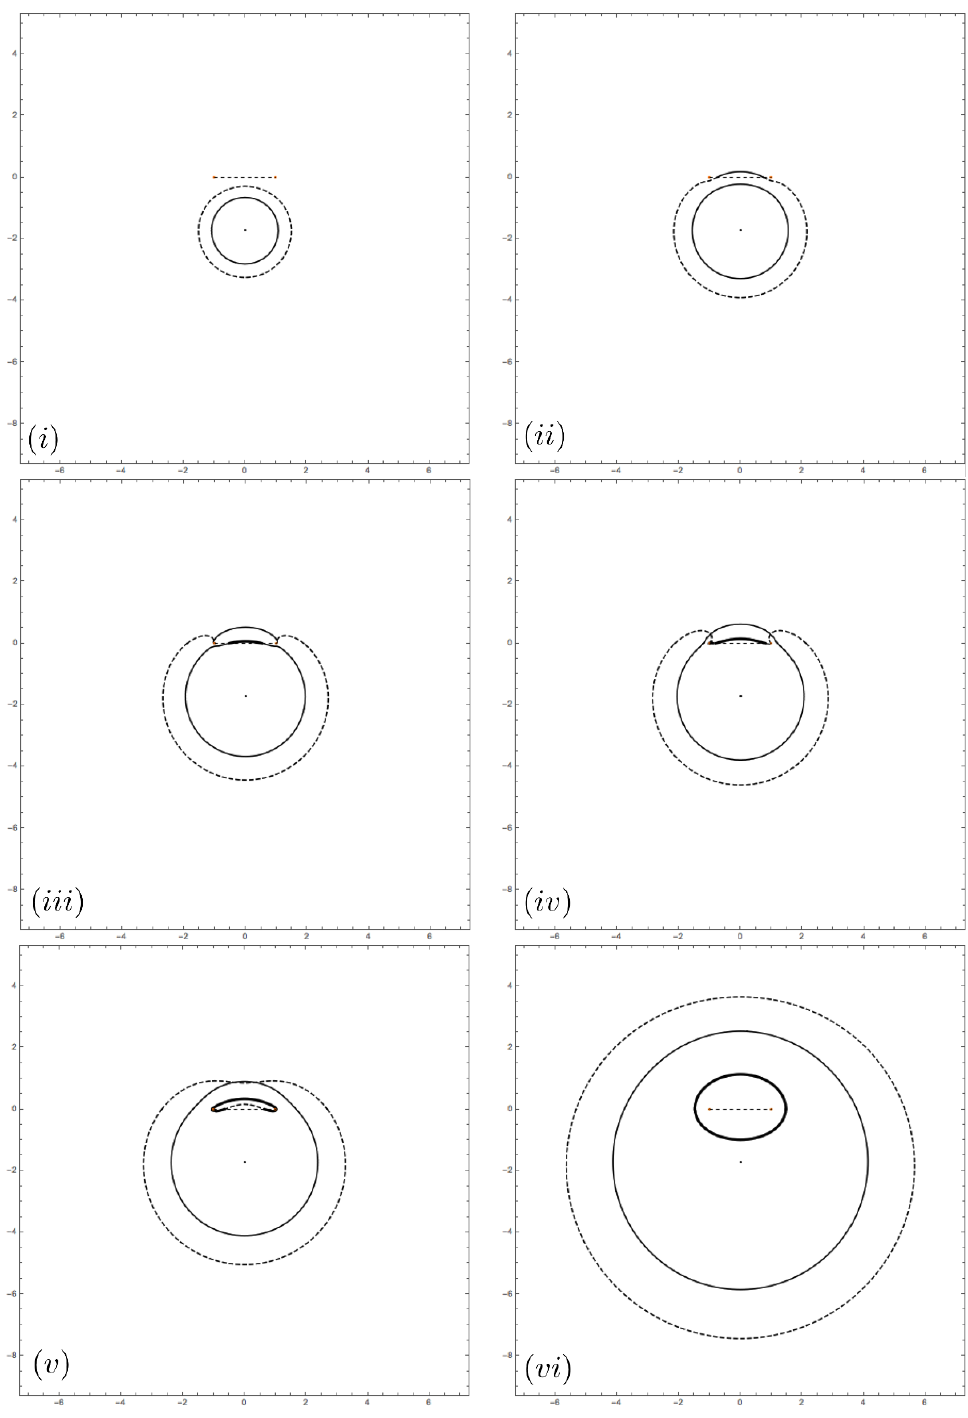
Figure 5 . An evolution of the giant graviton pro(cid:12)les for a process with two initial concentric giants and three (cid:12)nal concentric giants in chronological order: the thin solid, dashed and thick solid lines indicate (projections of) the equipotential surfaces in the 1st-, 2nd- and 3rd-sheets. The horizontal dashed segment and the black point are the branch three-ball and the point charge, respectively. The splitting interaction is happening from (ii) to (v) through the branch.